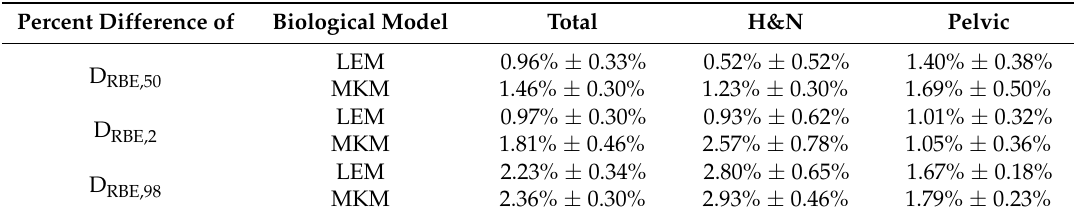
Table 5. Average percent variation of target D RBE,50 , D RBE,2 , and D RBE,98 , with respect to MC calculations for carbon ion patient cases applying LEM and MKM biological models. The values represent the mean ± standard error of the